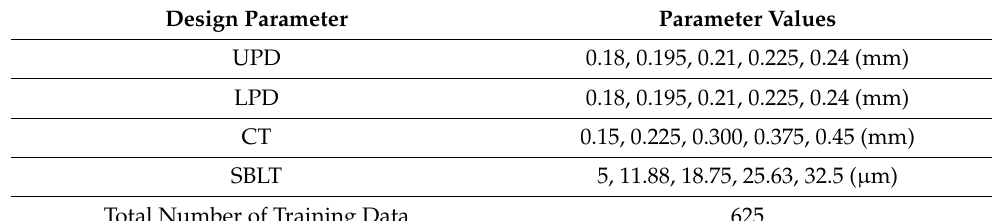
Table 7. Design parameters for 625 training data.